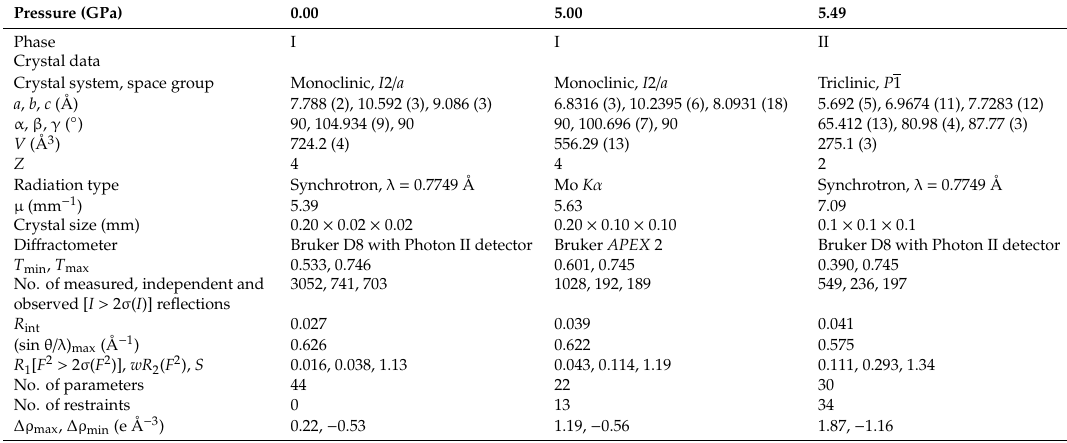
Table 5. Experimental details for the ambient pressure structure, and structures immediately below and above the phase transition. For all structures: C 7 H 4 IN, M r = 229.01. Experiments were carried out at 298 K. H-atom parameters were constrained. CCDC deposition numbers for the structures listed are 1911442, 1911457, and